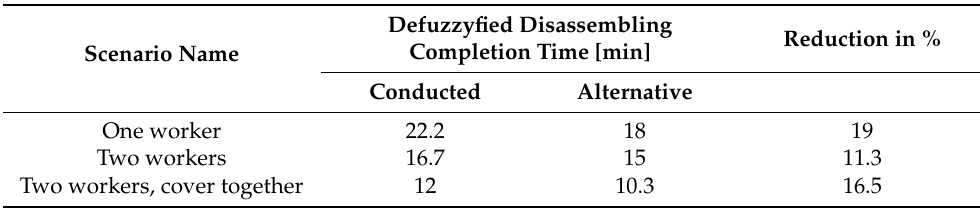
Table 7. Comparison of defuzzyfied disassembling completion time for different scenarios and plug removal techniques.